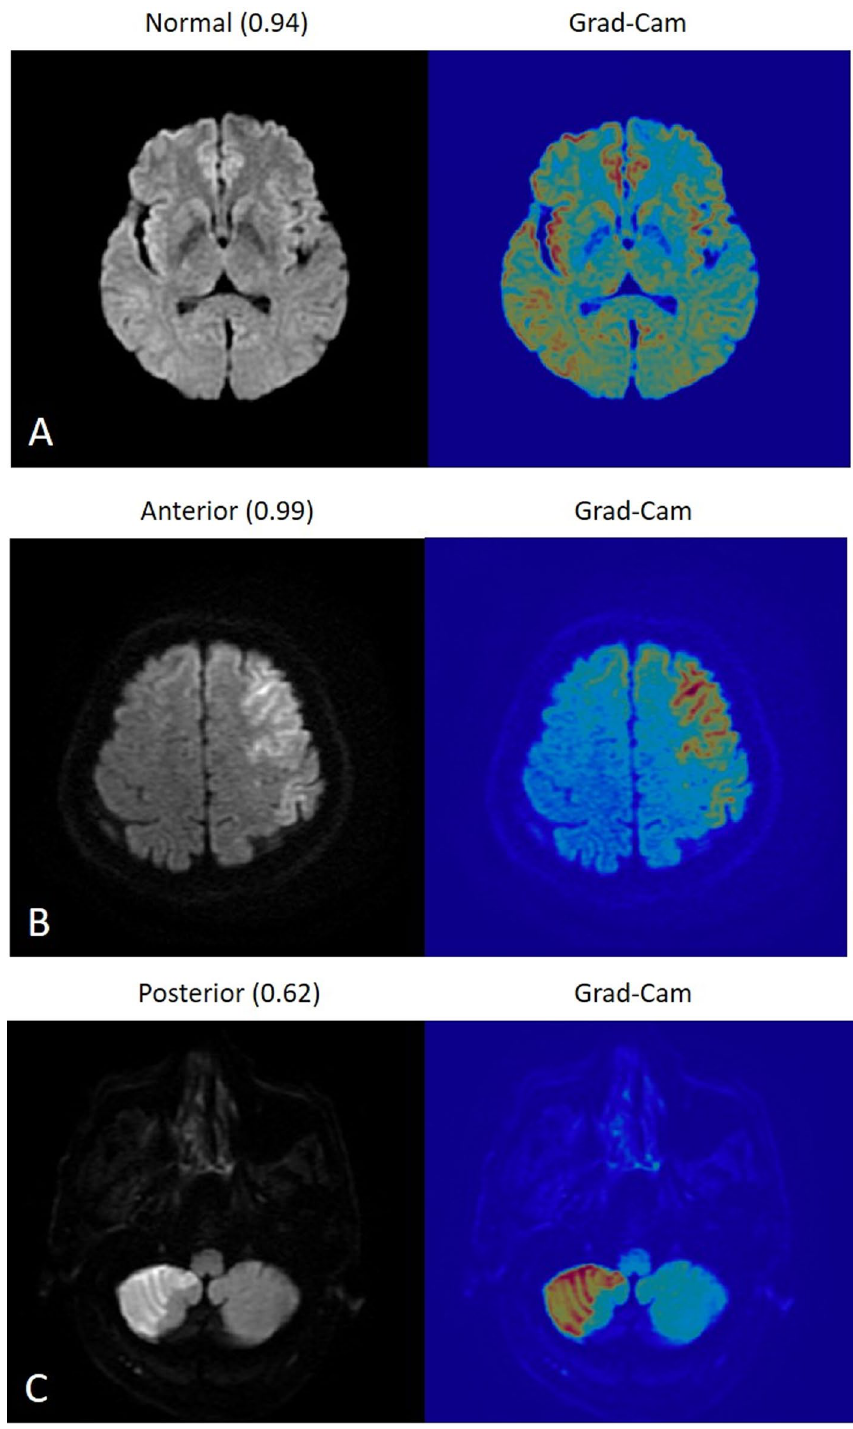
Figure 2. Example images that were correctly classified by the modified LeNet model, the first case was normal ( A ), the second one was left frontal and parietal infarction which was correctly classified into ACI ( B ), and the third one was right cerebellar infarction which was correctly classified in PCI ( C ). The number in bracket represent classification